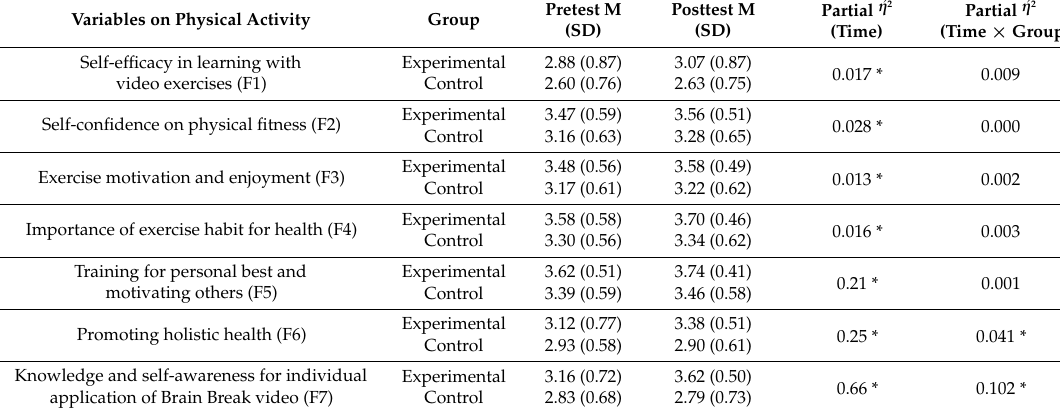
After the intervention and effects of the experimental factor ‐ implementation of Brain Break video exercises, the differences in means between the experimental and the control groups at post ‐ test are statistically significant. These differences all showed greater effects in the experimental group because of the impact of the experimental intervention. Obtained indicators for Partial ή 2 (Time) according the analyses of Cohen (1988) [60], where values >0.14 indicate a great effect of the time. The interaction of the time and the group Partial ή 2 (Time × Group) is analyzed based on the values of Wilk’s lambda. According to the results for this parameter presented in Table 4, it could be noted that the impact of the interaction of the variables time and group are statistically insignificant ( p < 0.05). Higher and statistically significant values for the indicator Partial ή 2 (Time × Group) are obtained for the last two factors (F6) Promoting holistic health and (P7) Knowledge and self ‐ awareness of individual application of Brain Break video. This indicates a significant difference between the two groups at pre ‐ test and post ‐ test. The gains from the pre ‐ test and post ‐ test are different in experimental and control groups, as indicated by the significant Time × Group effect. As illustrated in Figure 1, the experimental group gained significantly more than the control group from the pre ‐ test to post ‐ test, resulting with substantially higher scores in the experimental than the control group at post ‐ test.